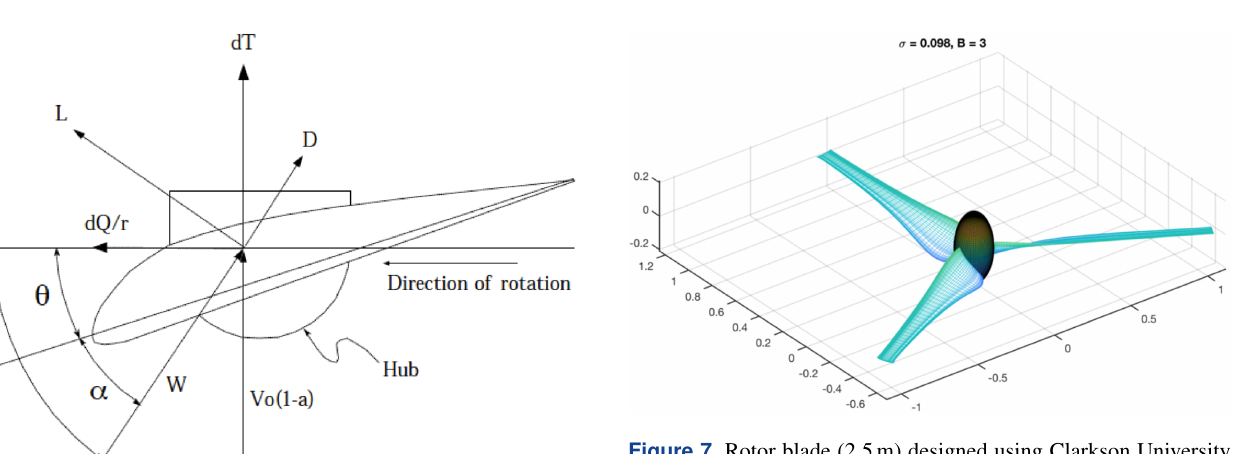
Figure 7. Rotor blade (2.5m) designed using Clarkson University mRotor